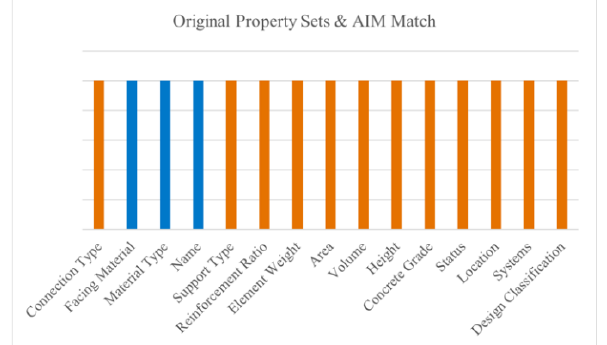
Figure 10 . Semantic Comparison of Information Loss (property sets transferred to AIM are highlighted in